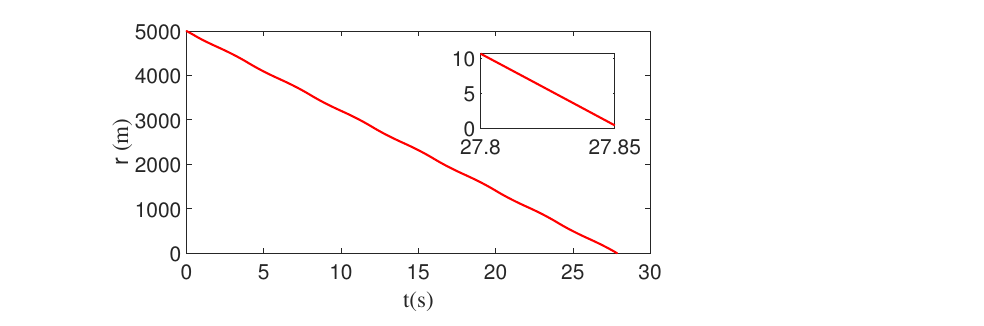
Figure 17. Time evolution of the relative distance between the missile and the target with square wave maneuver.